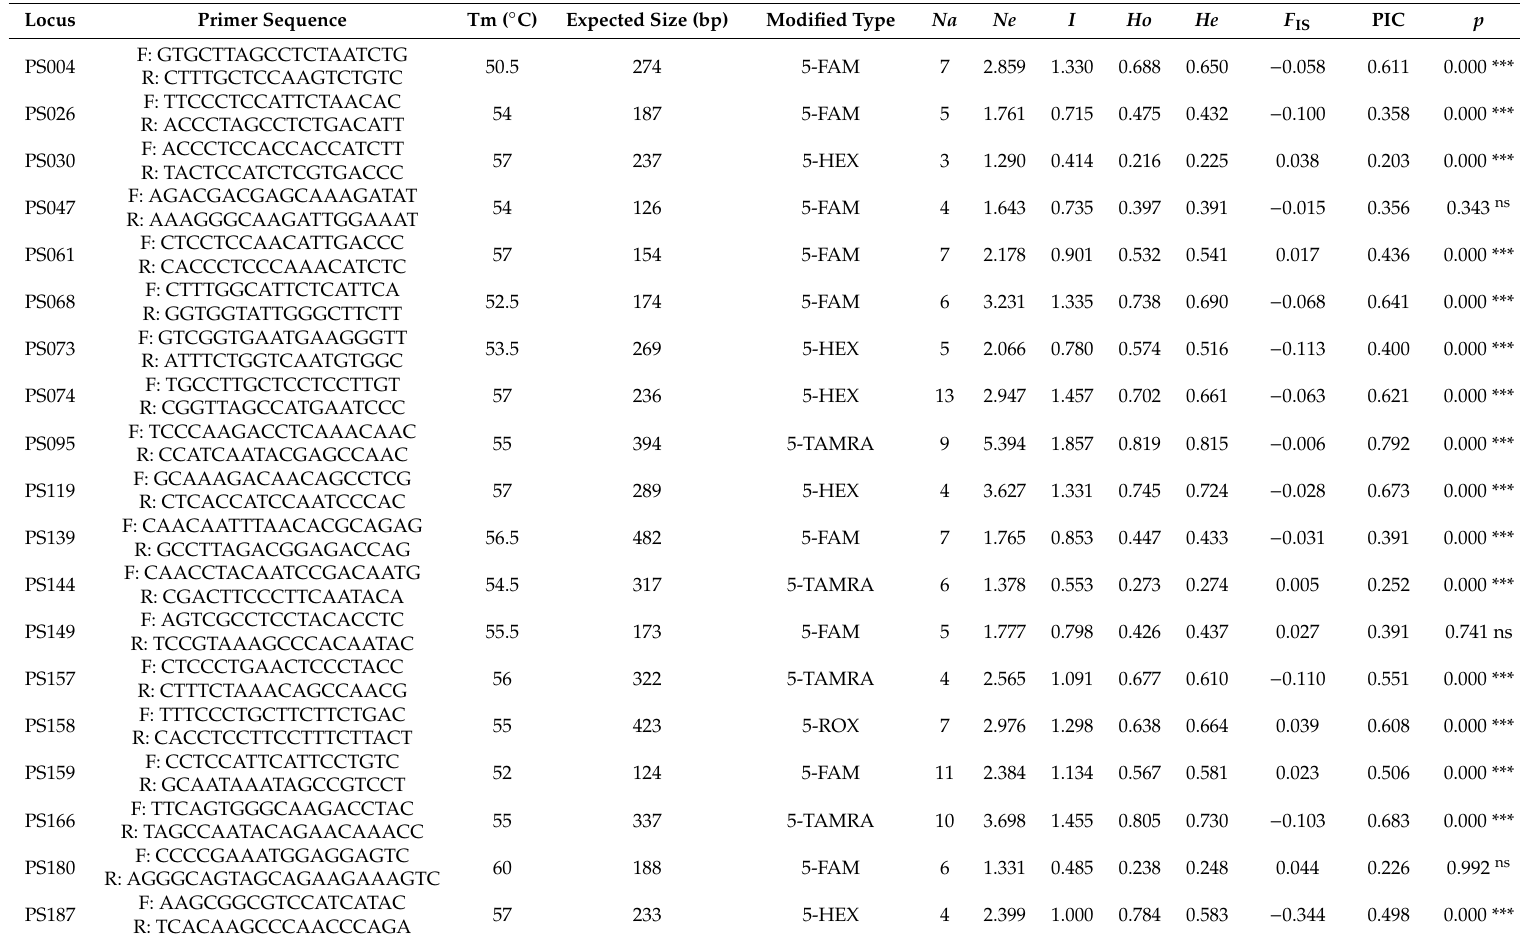
Table 2. Characterization of 34 simple sequence repeat loci based on 282